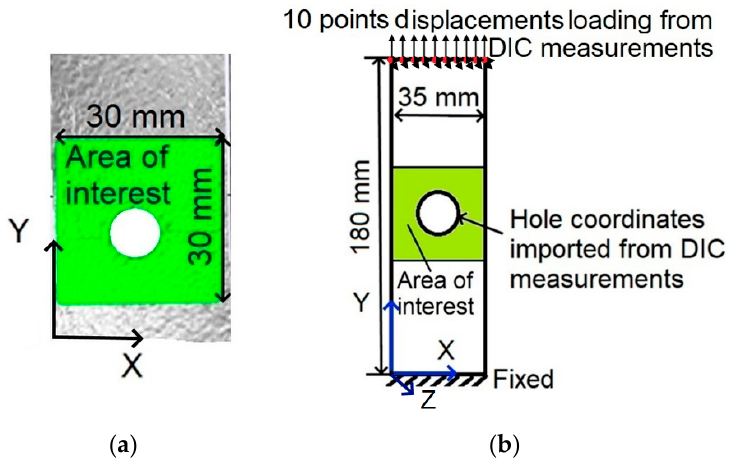
Figure 6. Computation scheme: ( a ) selected area of interest on the specimen surface for the DIC-PPDO calculation; ( b ) loading scheme of the specimen FE model.